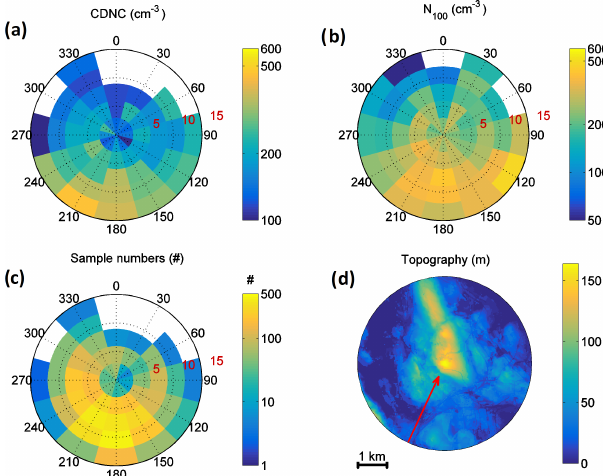
Figure 2. CCN dependence on wind speed and direction: (a) CDNC, (b) N 100 , and (c) number of CDNC samples. (d) To- pography of the area around Puijo hill, with the wind direction used in the simulations marked as red